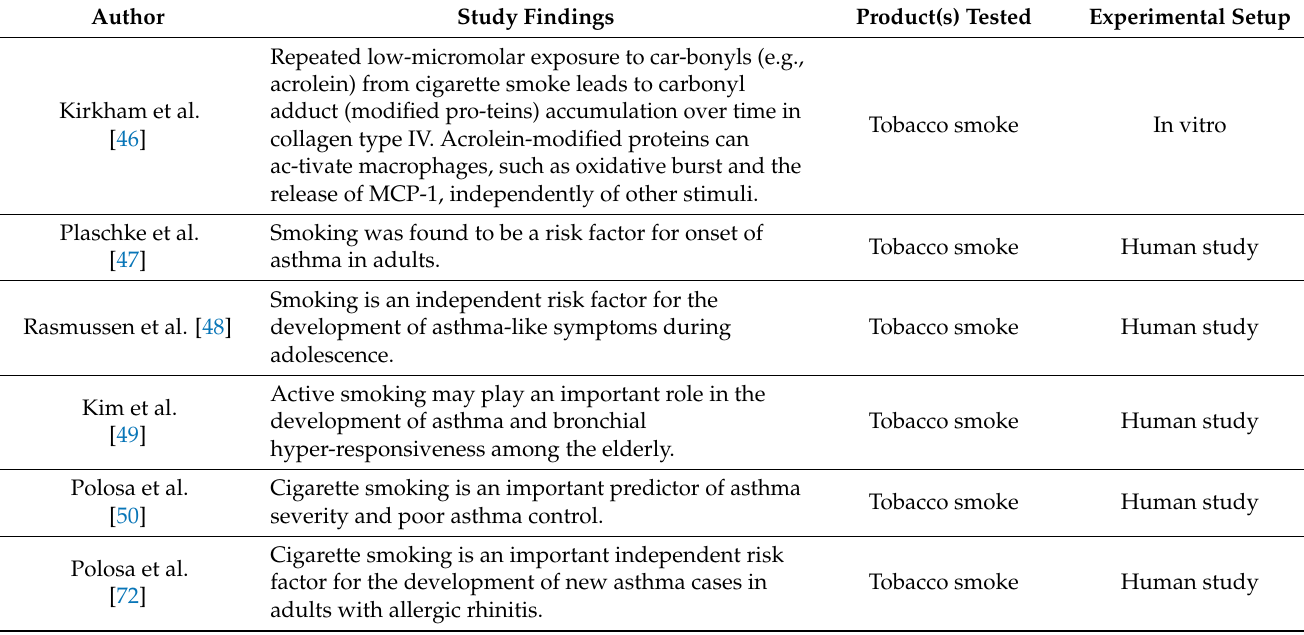
Table 1. Relevant research on oxidative stress related to tobacco smoke and NGP aerosols in respira- tory